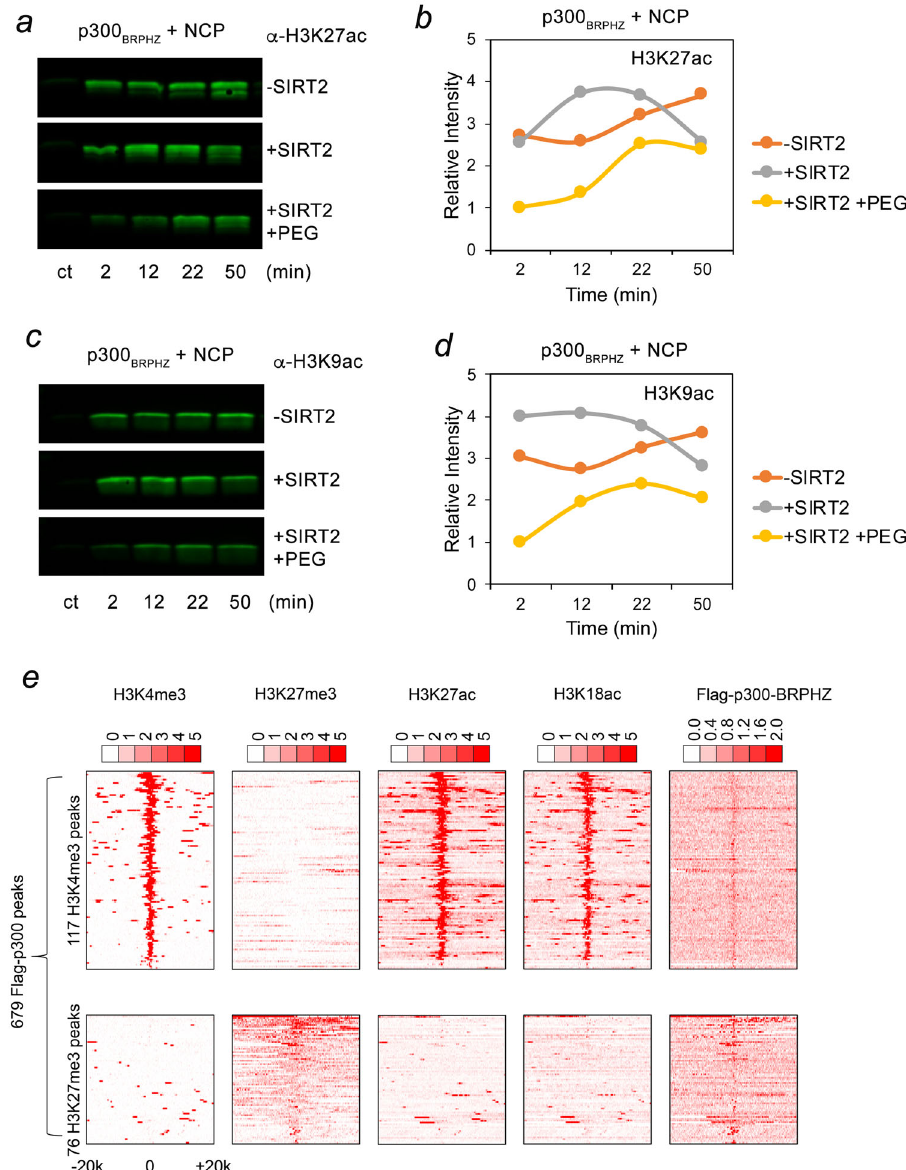
equimolar amount of NCP as a substrate. Reactions were quenched by rapid freezing and the addition of SDS-loading buffer at indicated time points. The intensity of bands is quanti fi ed, normalized to the + SIRT2/ + PEG band at 2 min, and shown in ( b ) and ( d ). e Heatmaps of H3K4me3, H3K27me3, H3K27ac, H3K18ac, and Flag-p300 BRPHZT , ChIP-seq signals centered on p300-H3K4me3 and p300-H3K27me3 binding sites in a ±20kb window in H1299 cells stably expressing FLAG-p300 BRPHZT . Heatmaps are ranked by H3K4me3 (upper panel) or H3K27me3 (lower panel). The color keys represent ChIP-seq densities normalized to total